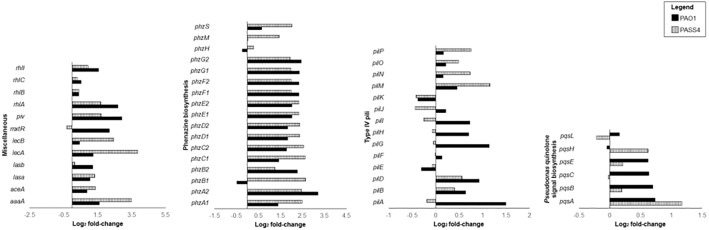
Differential gene expression (log2 fold-change) of virulence genes when P. aeruginosa strains PASS4 and PAO1 were grown in DNA compared to asparagine.